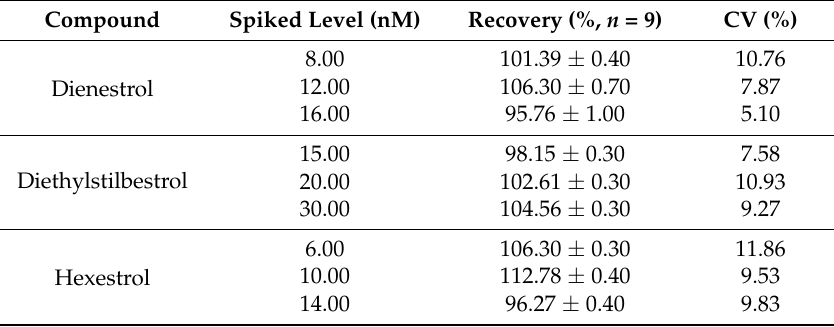
Table 2. Recovery and coefficients of variation (CV) of stilbenes in milk ( n = 3). Recovery ± standard errors are presented.